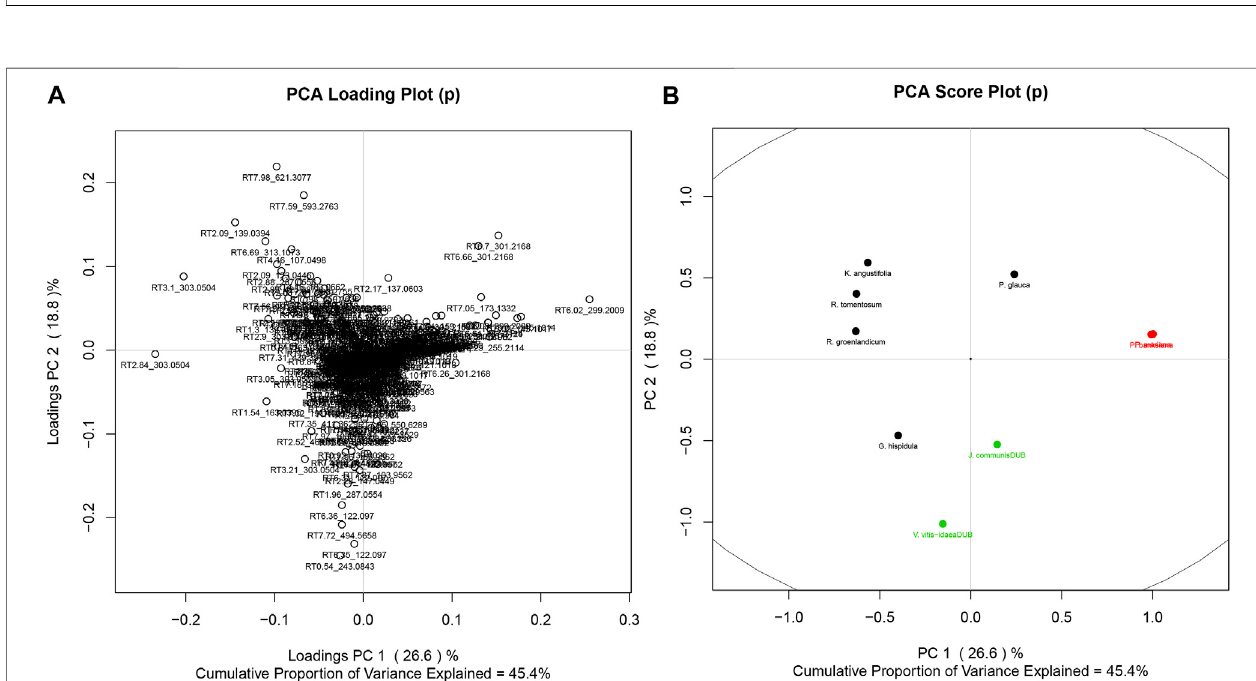
FIGURE 7 | PCA of Cree medicinal plants, grouped by speci fi c plant parts, namely leaves (black), berries (green), and cones (red). (A) PCs 1 and 2 for the metabolomics signal loadings. (B) PCs 1 and 2 for plant scores.